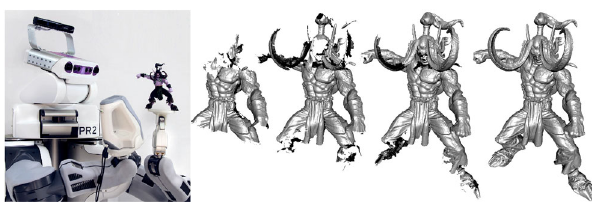
Fig. 8 Robot and modeling results. Reproduced with permission from Ref. [40], c (cid:2) ACM 2014.